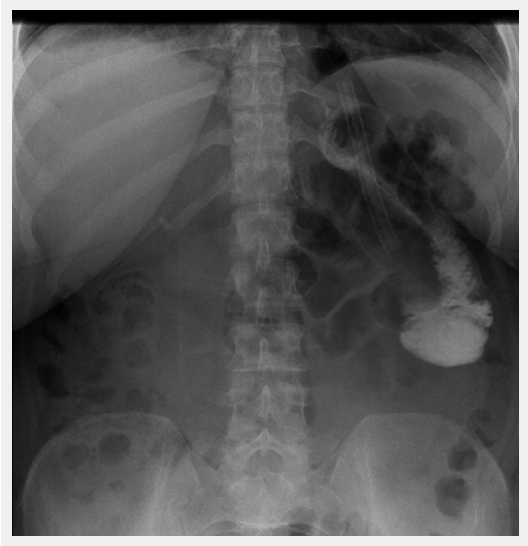
Upper Gastrointestinal series showing a stomal obstruction at the level of the gastrojejunal anastomosis.